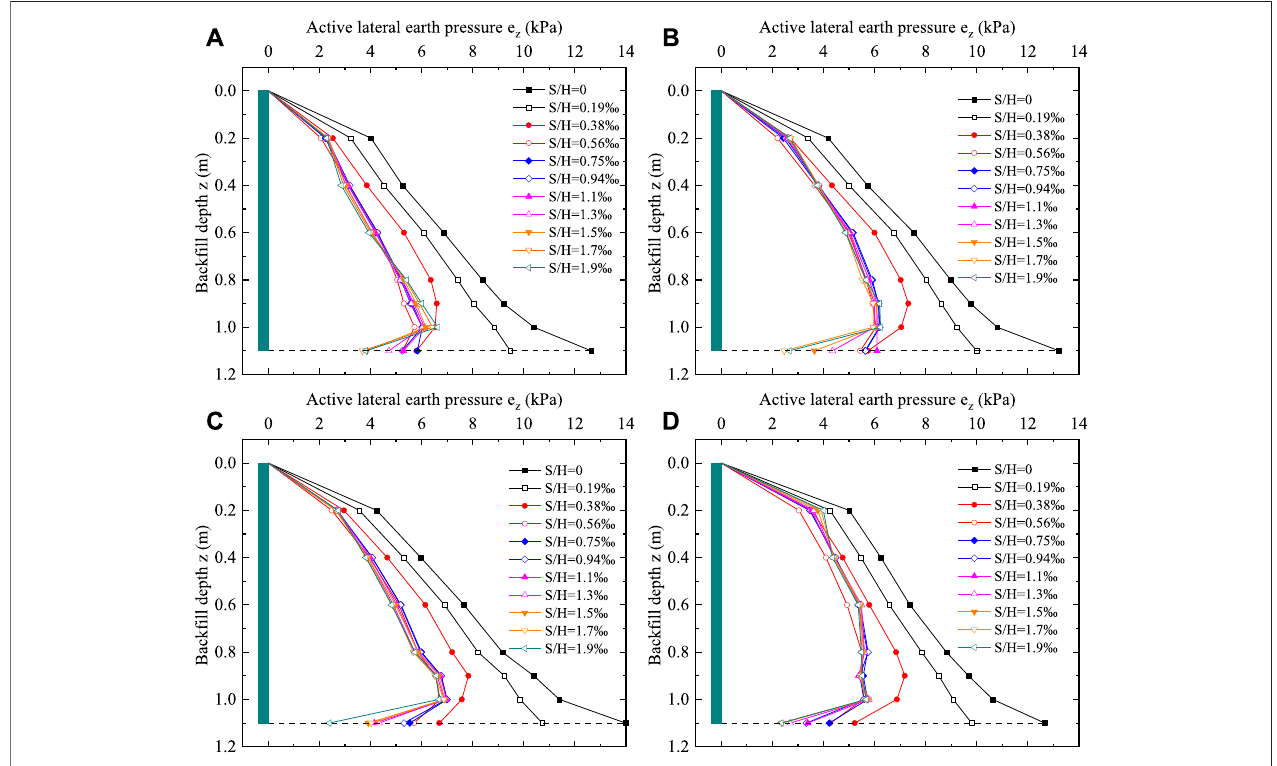
FIGURE 13 | Finite element modeling of active lateral earth pressure in the T displacement mode of retaining walls. (A) β = 40 ° . (B) β = 50 ° . (C) β = 60 ° . (D) β = 70 ° .